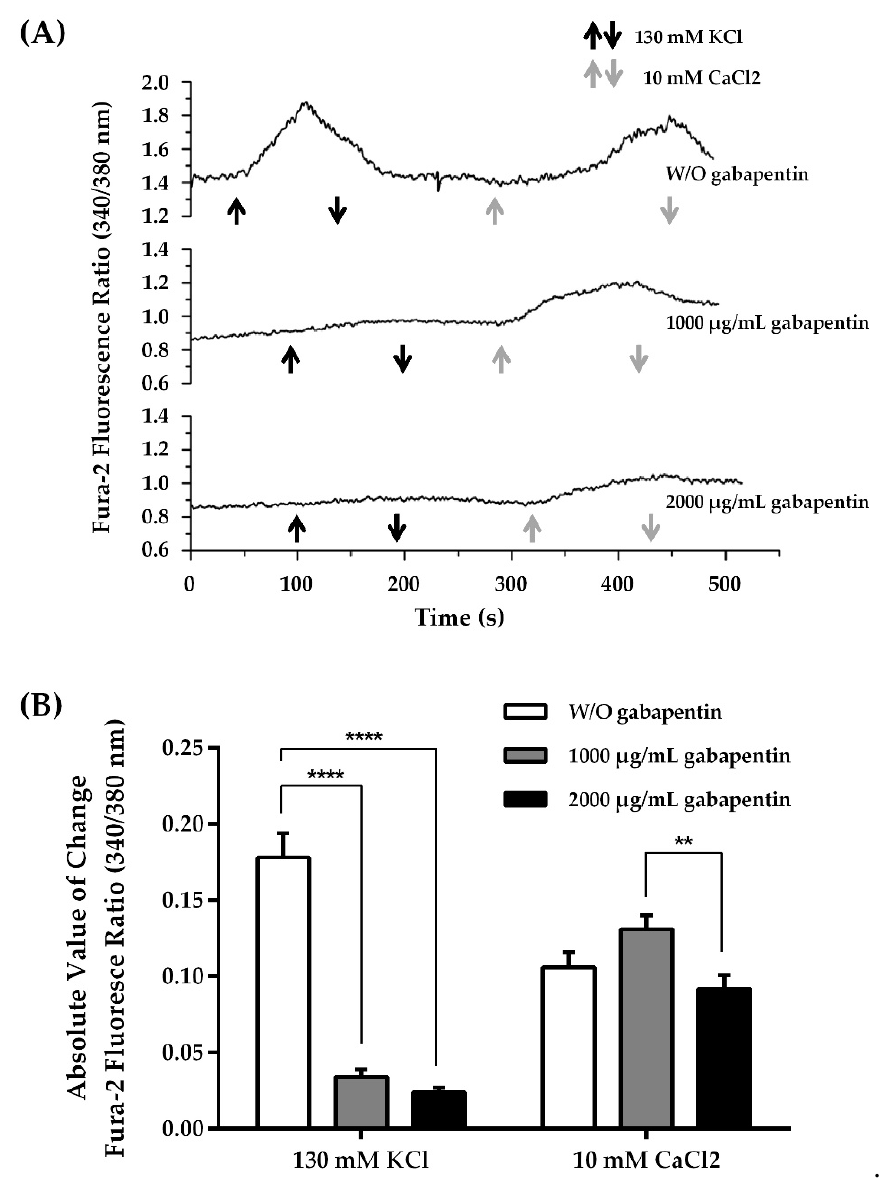
Figure 7. Calcium influx: Effect of gabapentin treatment on calcium influx in B16–BL6 murine melanoma cells: ( A ) Representative records showing changes in the time course of Fura-2 fluorescence ratio (340/380 nm) induced by 130 mM KCl or 10 mM CaCl 2 , in control and gabapentin-treated cells (1000 or 2000 µ g/mL). Cells were preincubated with gabapentin for 24 h before starting the experimental procedure, and maintained throughout the recordings. When exposing the cells to 130 mM KCl (black ↑↓ ), gabapentin caused calcium influx inhibition. Once the basal calcium level was recovered in the control condition (1mM CaCl 2 ), the subsequent exposure to 10 mM CaCl 2 (grey ↑↓ ) induced an increase in calcium levels in all conditions. ( B ) Summarized data showing the absolute value of change (experimental condition baseline) of transient calcium responses after 130 mM KCl or 10 mM CaCl 2 exposure in control and gabapentin-treated cells, expressed as Fura-2 fluorescence ratio (340/380 nm). Bars represent the mean ± SEM of data from control cells ( n = 32) and gabapentin-treated cells ( n = 17 under 1000 µ g/mL, and n = 28 under 2000 µ g/mL). ** p = 0.0061; **** p < 0.0001 vs. control.